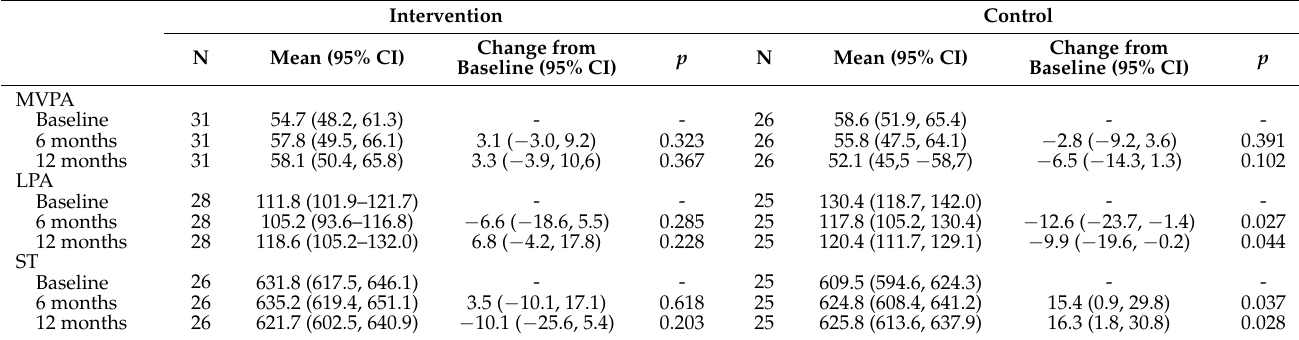
Table 2. Within-group changes in physical activity and sedentary time from baseline to 12-month